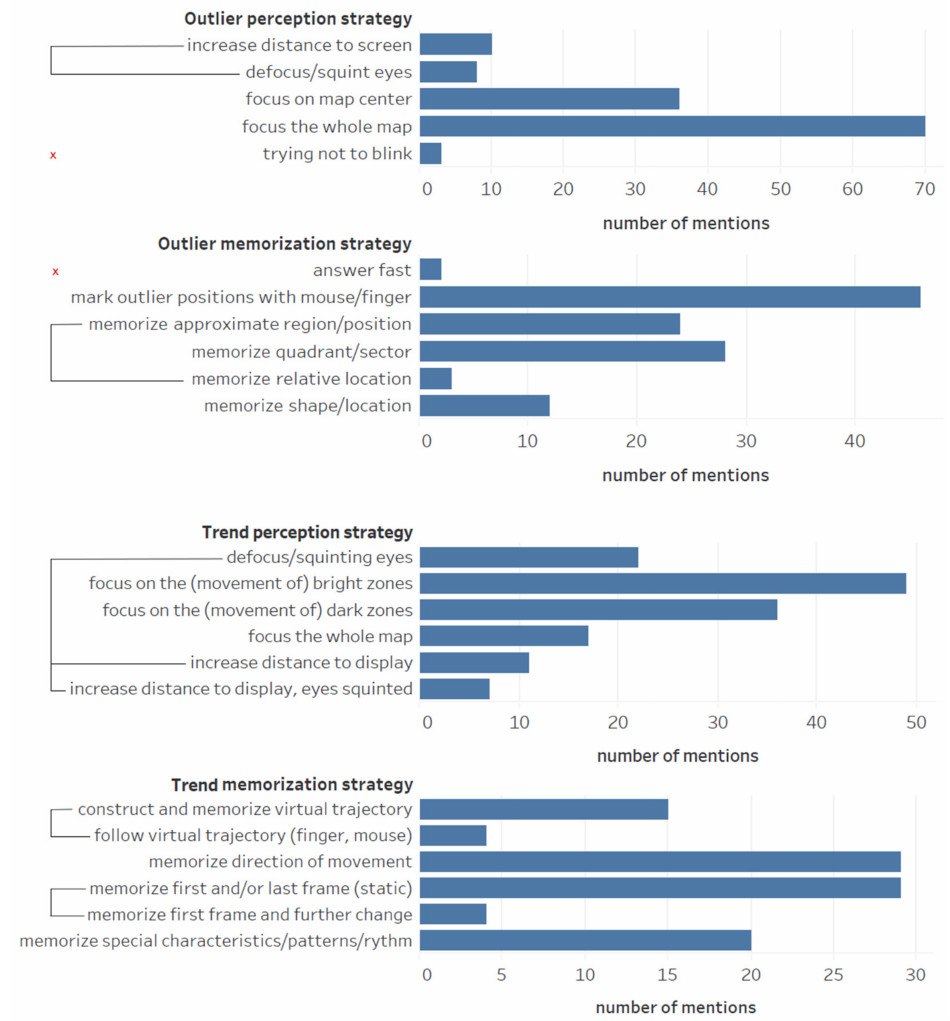
Figure 13. Strategies for outlier and trend detection and